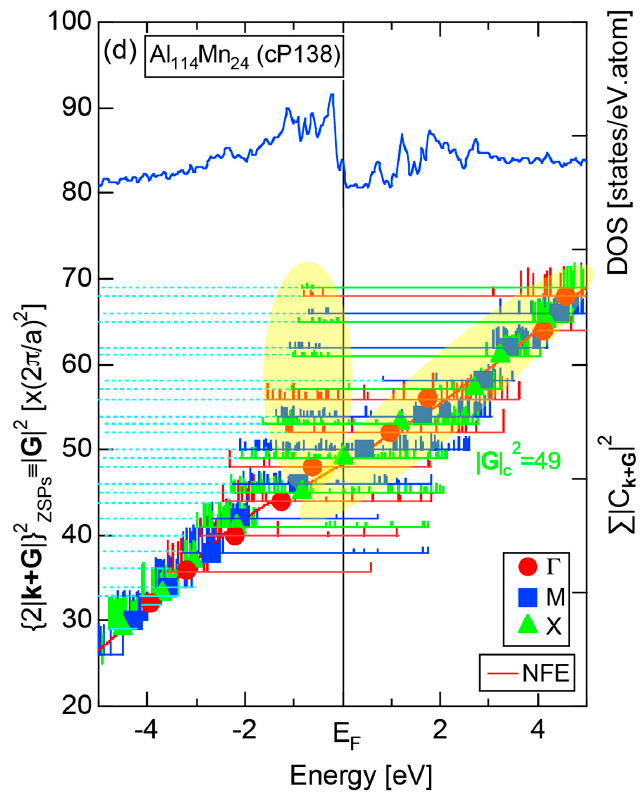
Figure 43. FLAPW-Fourier spectra at symmetry points Γ , M, X of simple cubic Brillouin zone for Al 114 Mn 24 (cP138) [11,18]. Formation of bonding and anti-bonding states due to Mn-3d-states-mediated splitting is highlighted by yellow